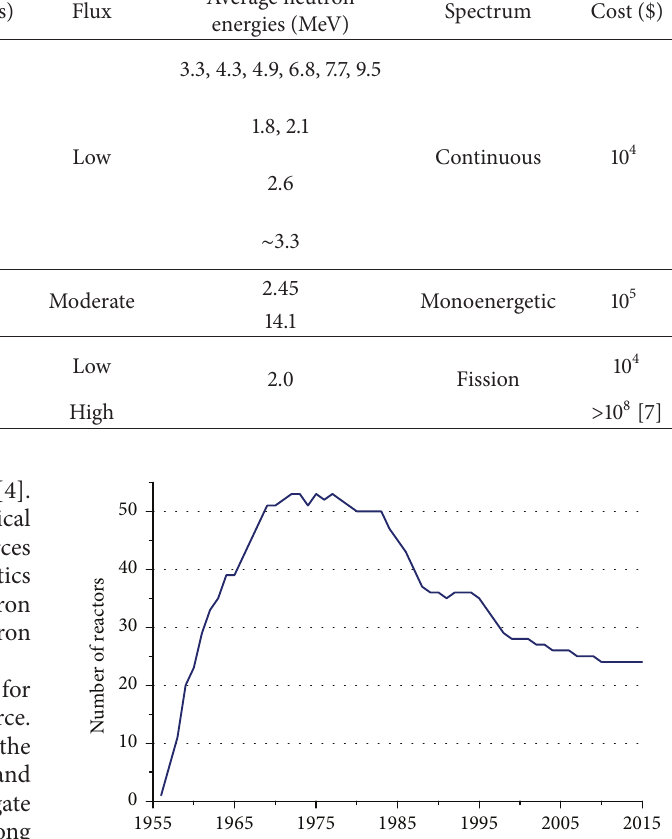
Figure 1: Nuclear Regulatory Commission licensed research reac- tors at US universities (does not include those at industrial and other government sites such as Department of Energy national laboratories); data are compiled from multiple volumes of